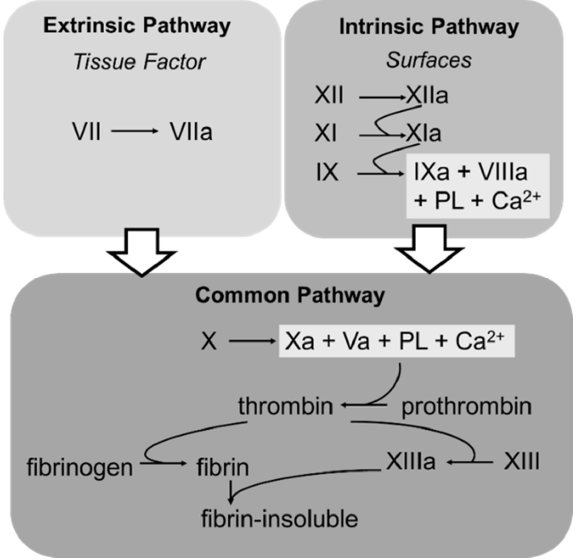
Figure 1. Schematic illustration of the intrinsic, extrinsic, and common pathway of the coagulation